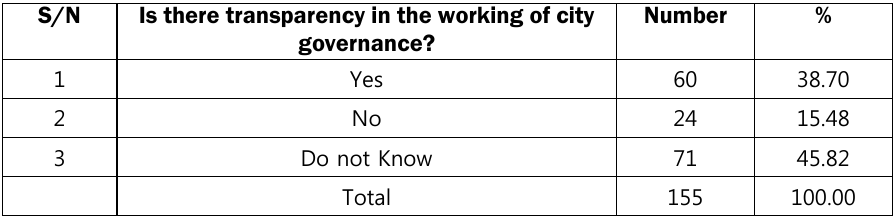
TABLE 6: Citizens’ views about transparency in the working of city governance S/N Is there transparency in the working of